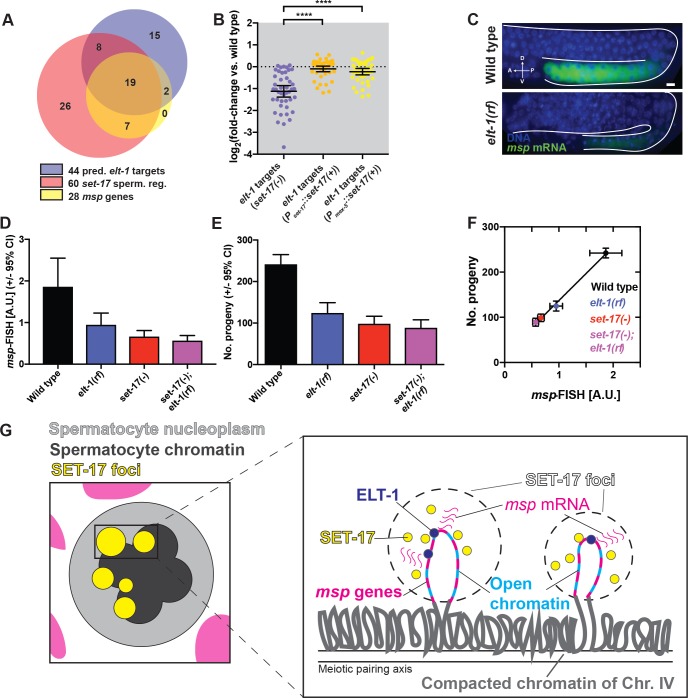
ELT-1 acts with SET-17 to promote spermatogenic gene cluster expression and fertility.A) Overlays among the sets of the 44 predicted spermatogenic elt-1 targets (from data of del Castilles-Olivera et al., 2009), the 60 spermatogenic set-17 misregulated genes (from our Fig 6A) and the 28 msp genes. B) Average log2-fold change in expression from RNAseq studies compared to the wild type for the 44 predicted elt-1 target genes in set-17 (purple), set-17; Pset-17::set-17(+) (orange) and set-17; Pmex-5::set-17(+) (yellow) mutant whole L4 hermaphrodite. **** P < 0.0001, MW or KS-test. C) Endogenous msp mRNA detection by smFISH in primary spermatocytes of elt-1 partial loss-of-function (rf) L4 hermaphrodites. Scale bar, 10 μm. D) Endogenous msp mRNA levels as visualized by smFISH in mature primary spermatocytes in wild-type (black), elt-1 (purple), set-17 (red) and set-17; elt-1 (magenta) L4 hermaphrodites. n > 15. E) Number of progeny of wild-type (black), elt-1 (purple), set-17 (red) and set-17; elt-1 mutants (magenta). n > 20. F) Fertility correlates with endogenous msp mRNA levels as visualized by smFISH (data from Fig 7C and 7D). Pearson-correlation r = 0.9981, P < 0.002 (2-tailed). G) Model of SET-17 foci composition and function in msp gene expression in primary spermatocyte nuclei at spermatogenic gene clusters. See text for details.